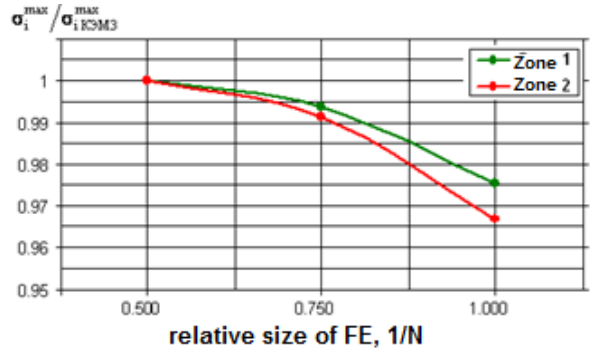
Below is a description of the main stages of the pre- sented computer technology.